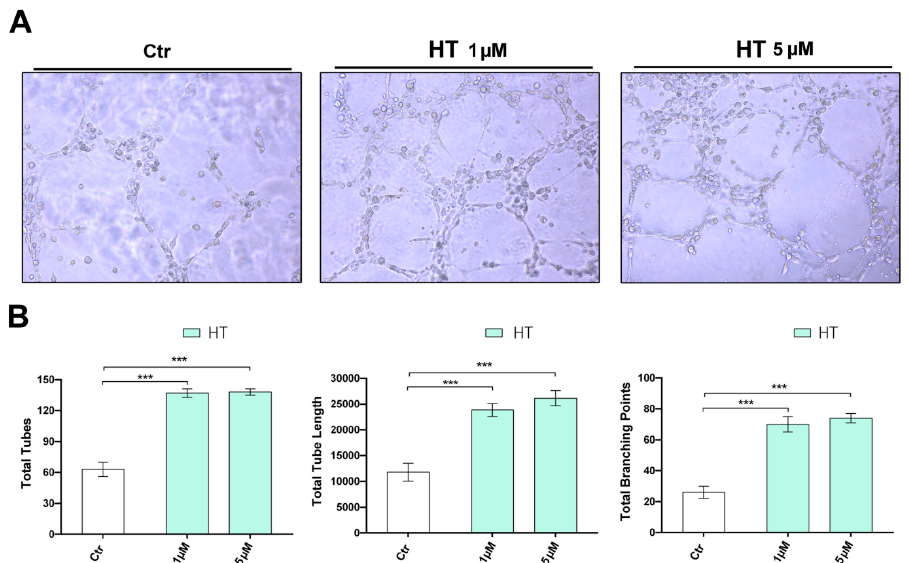
Figure 4. Effect of HT on tube formation. Pro-angiogenic benefit of HT on HUVECs tube formation was examined using a Matrigel assay. Tubular structures were photographed at 100 × magnification ( A ), and total tubes, the total tube length and total branching points were measured ( B ). Results are shown as mean ( ± D) (2-way ANOVA, *** p < 0.001). Int. J. Mol. Sci. 2020 , 21 , x FOR PEER REVIEW